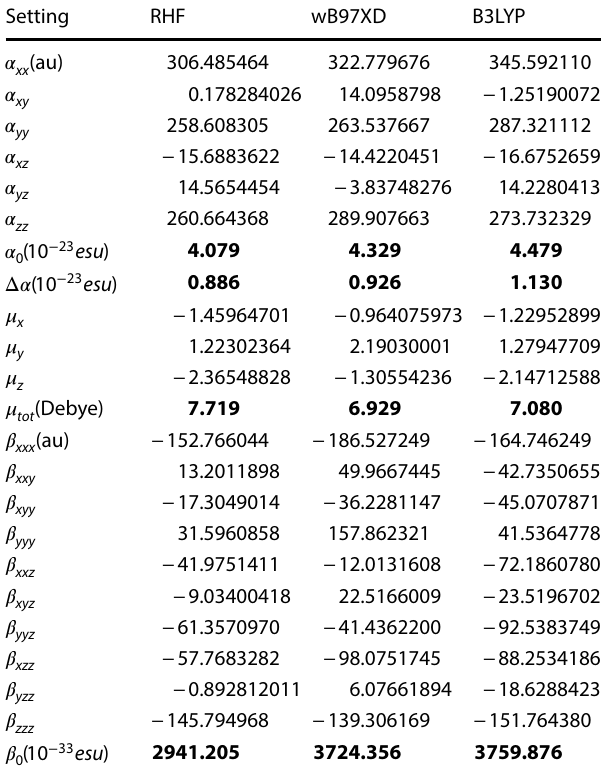
Table 7 Values of the components α and β of andirobin calculated by RHF, B3LYP and wB97XD methods with 6–311 G(d,p) basis